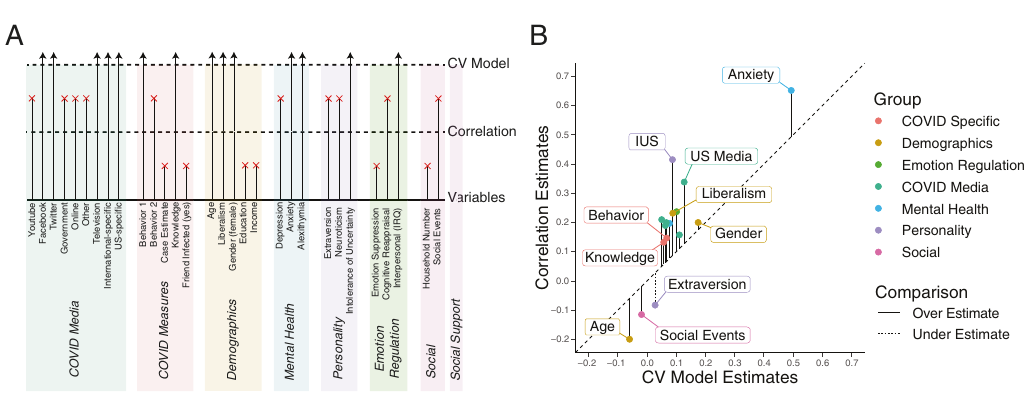
Fig. 1 Predicting Covid-19 Emotional Distress. A Relationships between variables and COVID-19 emotional distress.All 30 variables are shown and ordered according to their category. The middle horizontal dashed line (Correlation) indexes whether the simple correlation of each variable with COVID- 19 emotion distress was signi fi cant (24 of 30 variables). The top horizontal dashed line (CV Model) indexes whether the variable survived the cross- validation procedure and was signi fi cant in the fi nal model (14 of 30 variables). B Comparing correlation and CV model estimates. CV model estimates refer to the beta coef fi cients in the cross-validated model while correlation estimates refer to Pearson ’ s coef fi cients. All variables were standardized (mean-centered and scaled). Only variables from the CV model are shown. The length of the comparison lines shows the degree to which variables were over-estimated (15/16) or under-estimated (1/16) when comparing the correlation to CV model estimates.